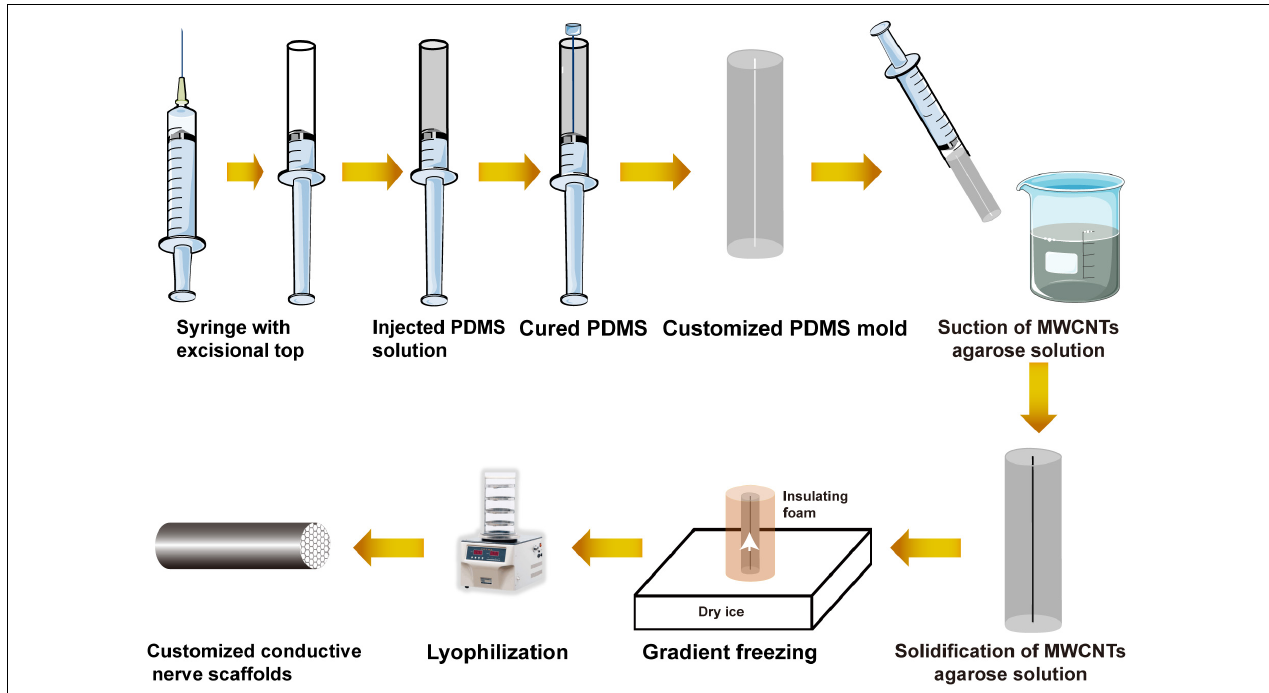
FIGURE 2 | Schematic diagram of the preparation of the customized conductive nerve scaffold with multi-microchannel.